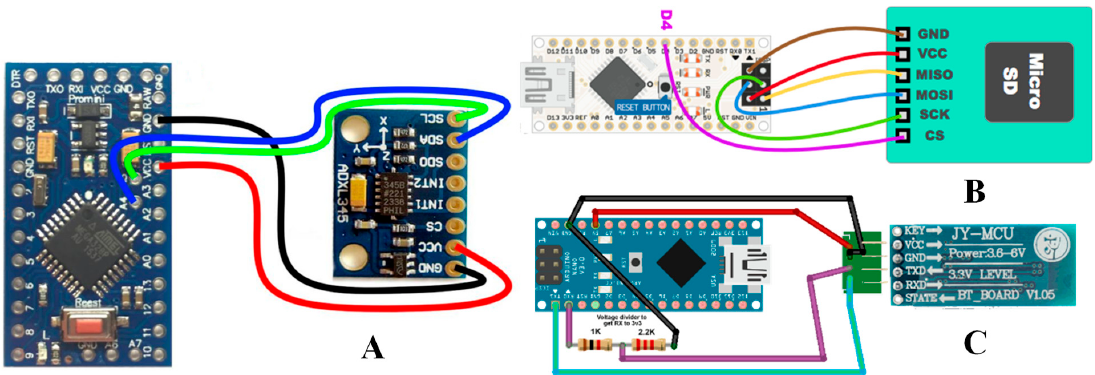
Figure 4. Arduino Nano interfacing wiring with ( A ) MMA7455, ( B ) Micro SD card module, and ( C ) Bluetooth Low Energy (BLE) module.